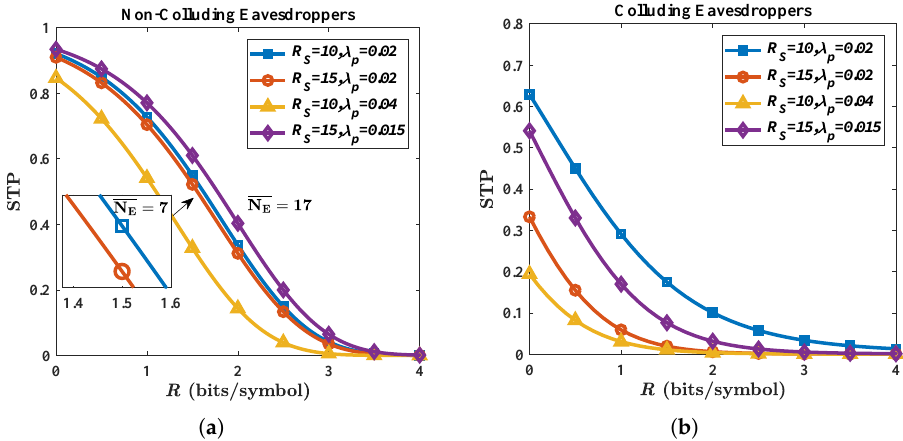
Figure 3. Secure transmission probability (STP) under different R S and λ p for ( a ) non-colluding case and ( b ) colluding case. Parameters are given by: G = 25 dBi; N = 5; f = 300 GHz; and P = − 10 dBm.